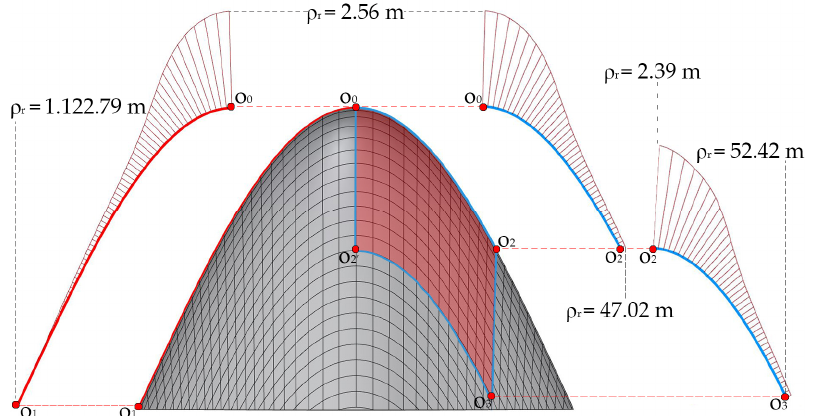
Figure 13. Test surface and curvature radius diagrams of the paths to the test points O 1 and O 3 . Table 1. Comparison of accuracy improvement and runtime of the Improved Compass Method (ICM) and the Adaptative Compass Method (ACM) over the Compass Method (CM). Accuracy Improvement (mm)